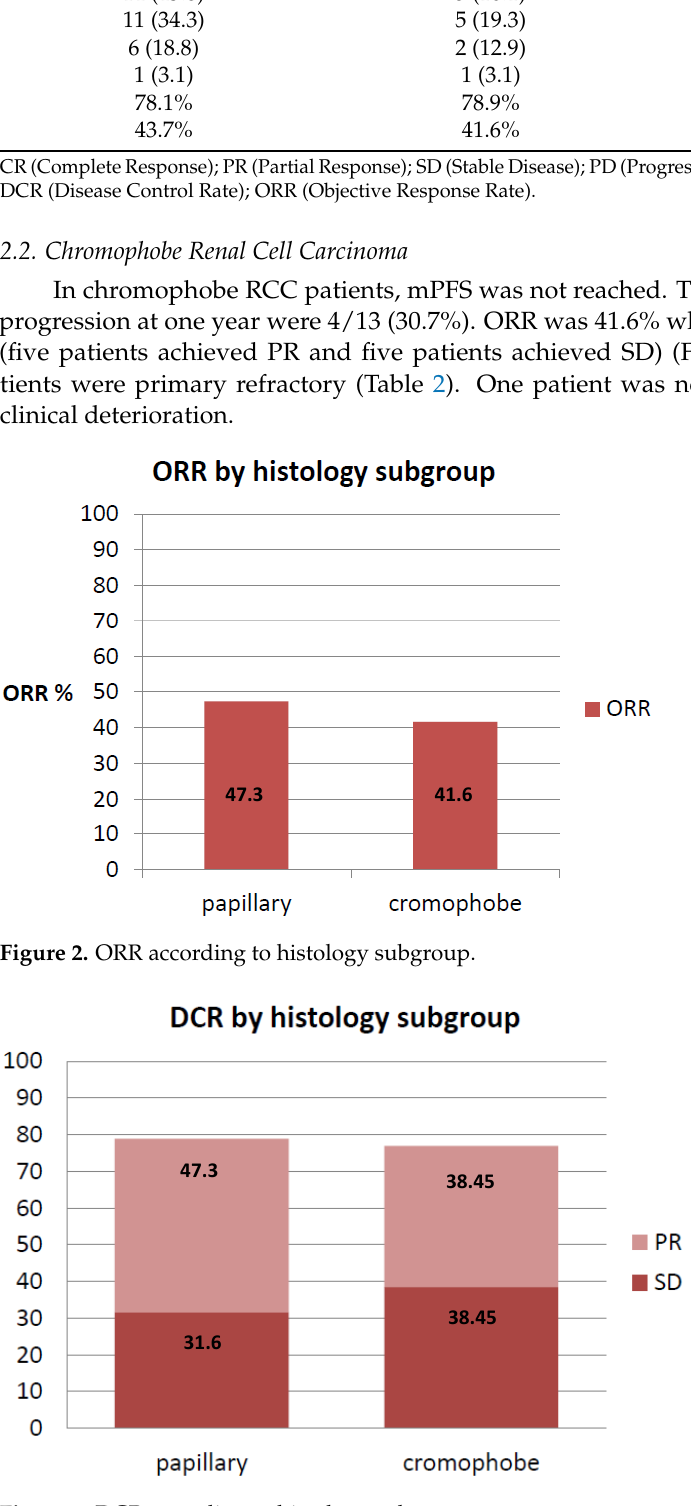
Figure 4. median Progression Free Survival (mPFS) in the papillary RCC patients was 10.8 months (95%CI 4.48 – 17.12). 3. Discussion Chromophobe and papillary renal cell carcinoma are a rare subtype of RCC, classi- fied as nccRCC, that account for 5% and 10 – 15% of RCC cases, respectively [9,10]. Favor- able prognosis is attributed to papillary type 1 and chromophobe-localized RCC whose cancer specific survivals at 5 years are 87.4% and 86.7% compared to 68.9% for ccRCC [11]. Otherwise, papillary type 2 is more aggressive and tend to rapid metastatic spread [12]. The choice of therapy for nccRCC is often a challenge and limited evidence is availa- ble to guide clinicians in treatment, due to its relative rarity. Although immune- Progression free 0